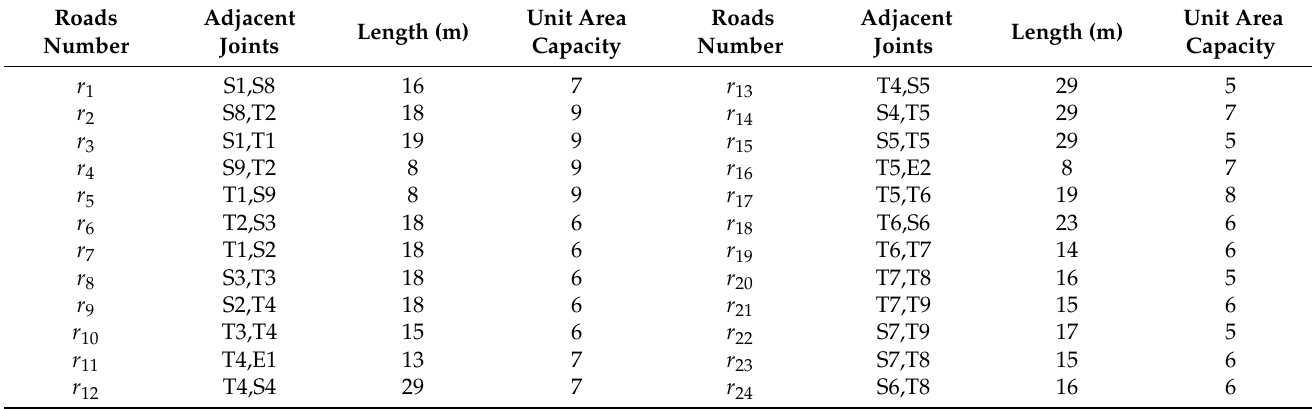
Table 2. Table of weights of adjacent nodes in the network topology